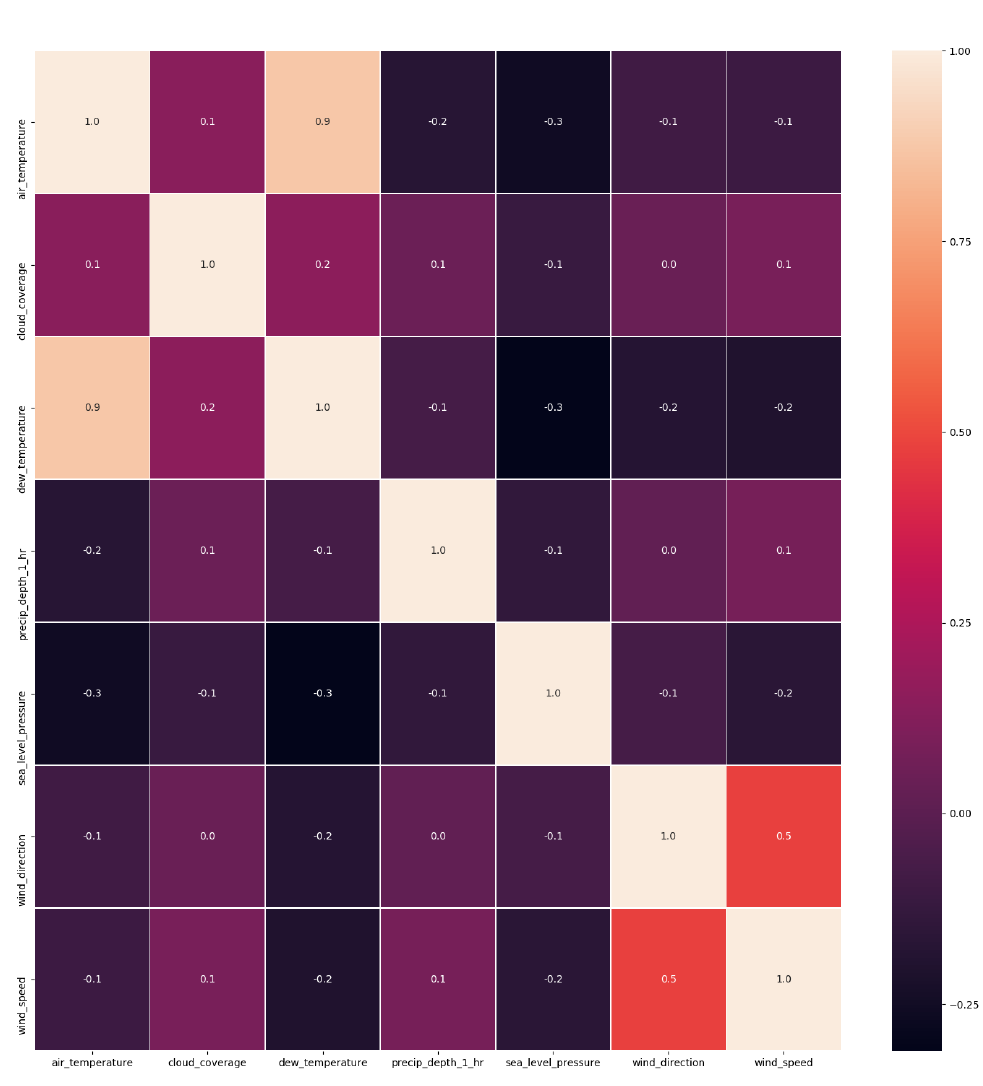
Figure 10. Correlation between selected variables.